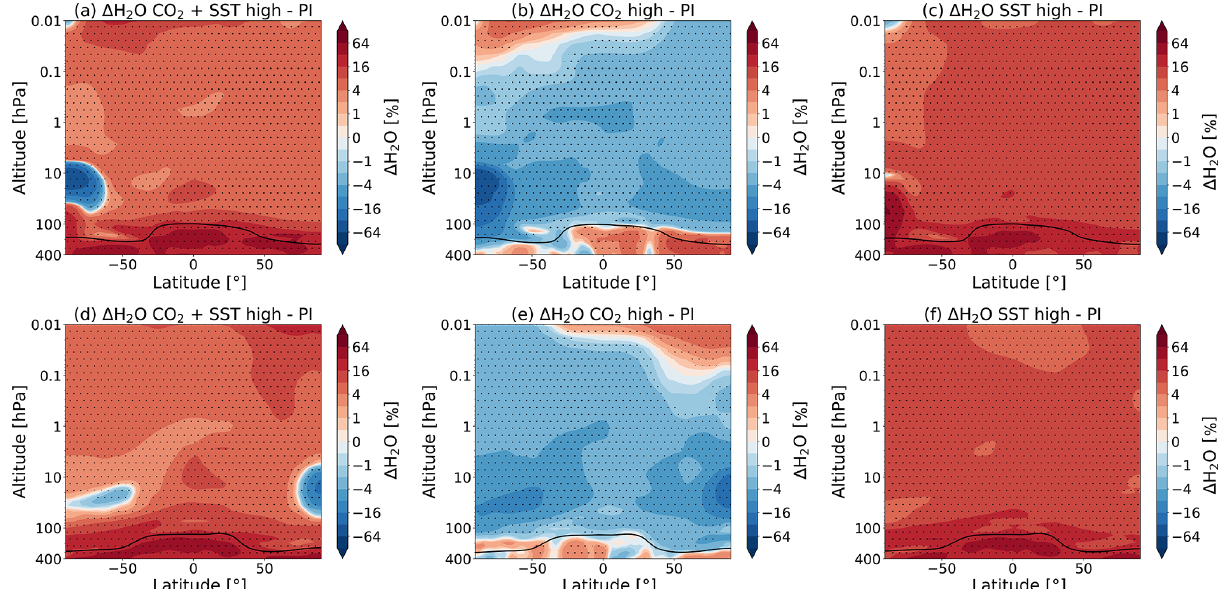
Figure 8. The percentage changes in the zonal and monthly mean water vapour mixing ratio for July (a–c) and January (d–f) due to (a, d) the combined effect of the CO 2 increase and SST changes (experiment S3–C1), (b, e) the doubling of the atmospheric CO 2 concentration (experiment S1–C1) and the (c, f) SSTs (experiment S2–C1), as simulated by WACCM. The dotted regions indicate the regions where the data reach a confidence level of 95%. The tropopause height is as indicated in Fig.